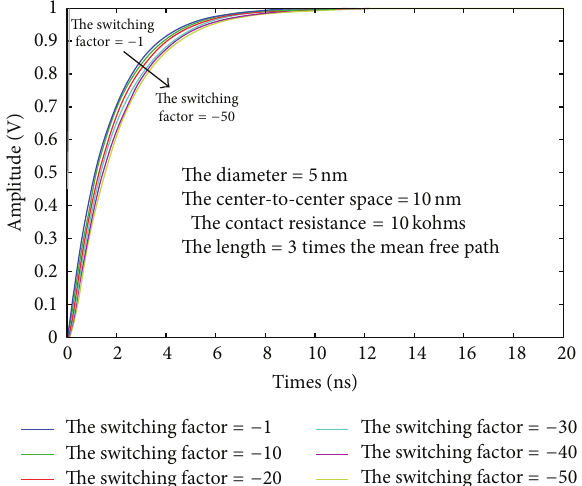
Figure8:Theoutputresponseoftheconfigurationin Figure 5tothe ramp input with the slope of 10 V / ns, using (22), for various values of the switching factor.